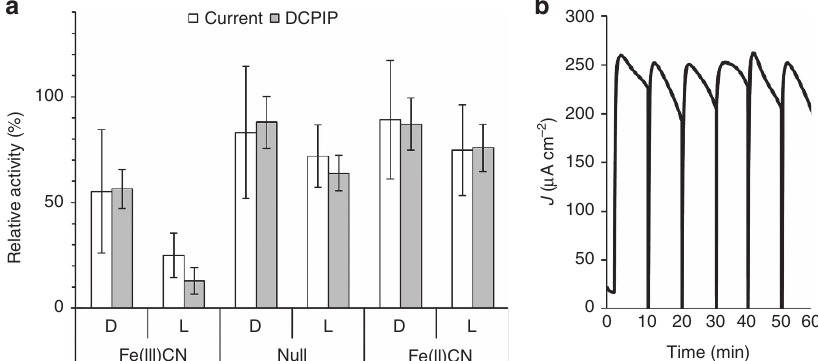
Figure 3 | Light-induced reduction of Fe(III)CN damages the photosynthetic activity of the thylakoids. ( a ) The residual photocurrent and DCPIP reduction obtained from thylakoids after incubation for 10min in the dark (D) or in light (L), without (null) or with 3mM Fe(III)CN or Fe(II)CN, normalized to a control experiment using identical thylakoids without incubation. The error bars represent the s.d. over five measurements. ( b ) Batch mode of operation wherein damaged thylakoids were replaced with fresh ones every 10min. All the other cell components were